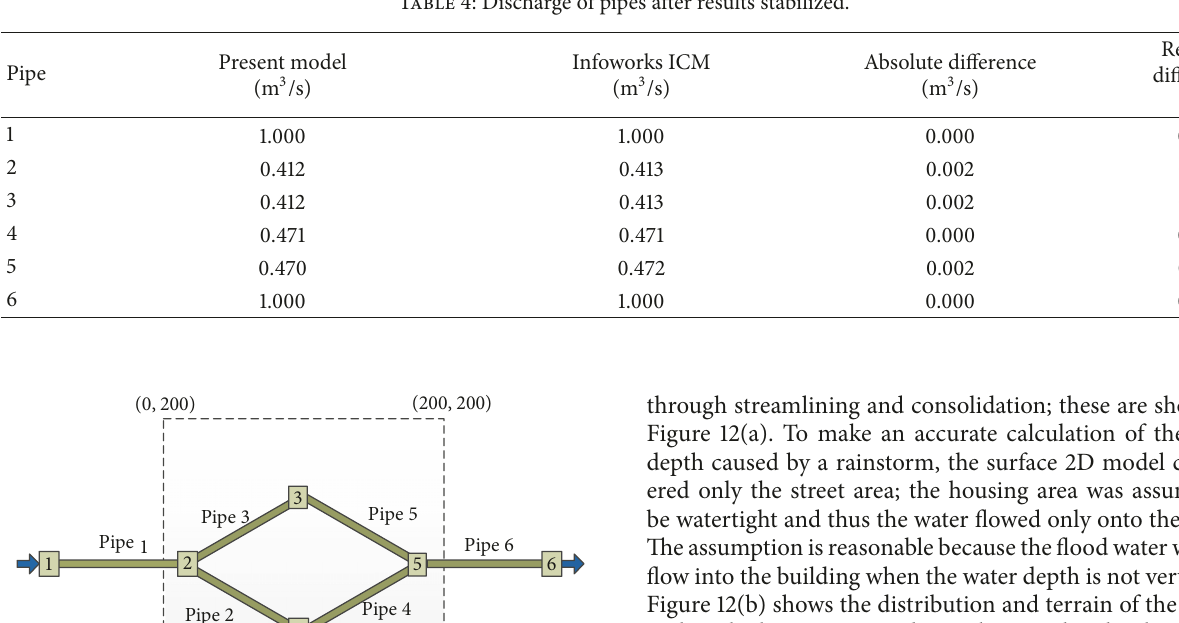
Table 4: Discharge of pipes after results stabilized.